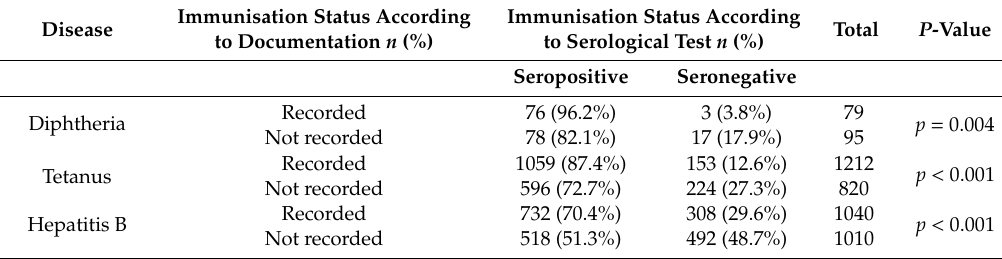
Table 5. Comparison between documentation recorded and serological tests performed in